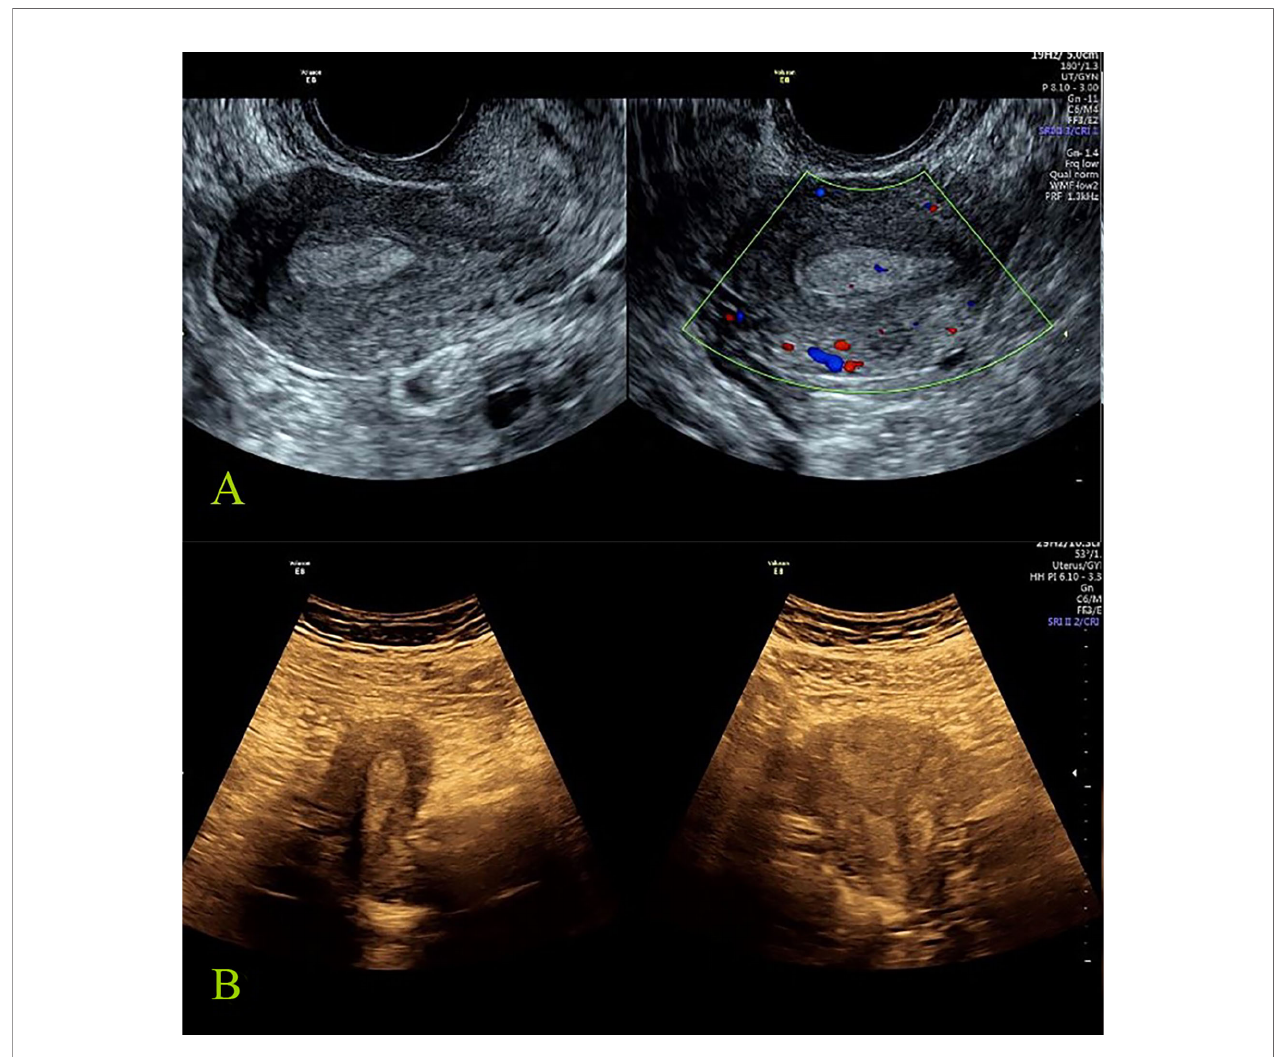
FIGURE 2 | Benign reference case: female, 27 years old, abnormal menstruation for more than 2 months. All the seven tumor biomarkers were normal, the postoperative pathology was endometrial polyp, and the total score of IETA ultrasound characteristics simple scoring method was: 3 points [endometrial thickness 10 mm: 0 point; heterogeneous without cysts: 1 point; regular endometrial – myometrial junction: 0 point; having “ Bright edge ” sign: 0 point; color score: minimal color/sparse vascularity: 2 point; single vessel (without branching): 0 point]. (A) The grayscale and color Doppler ultrasound images of endometrial polyp (transvaginal scan). (B) The grayscale images of endometrial polyp (transabdominal